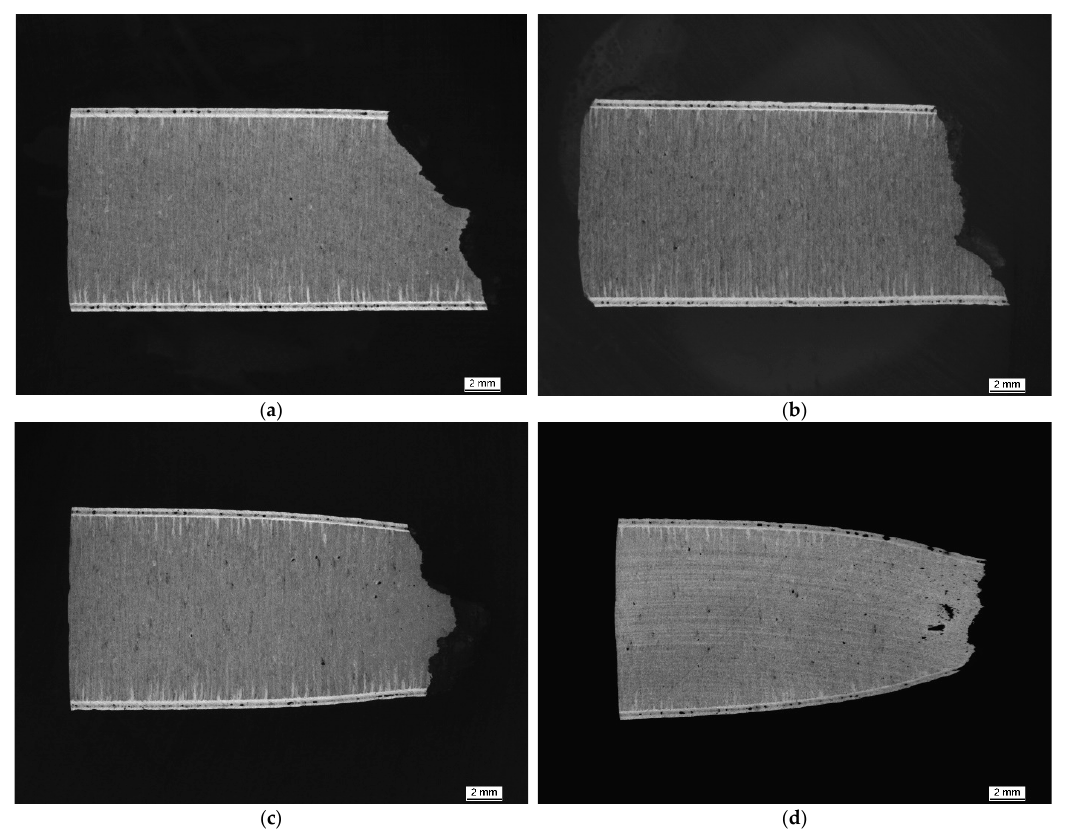
Figure 7. Macroscopic images of metallographic sections of tensile test samples produced at a polar angle of 0° and tested at increasing temperatures, after grain boundary etching using MIL etchant: ( a ) RT, ( b ) 125, ( c ) 250 and ( d ) 450 °C. Figures show increasing levels of necking parallel to the in- creasing test temperature. Etching highlights the orientation of the individual layers, perpendicular to the direction of force in this case, as well as the boundary layer.